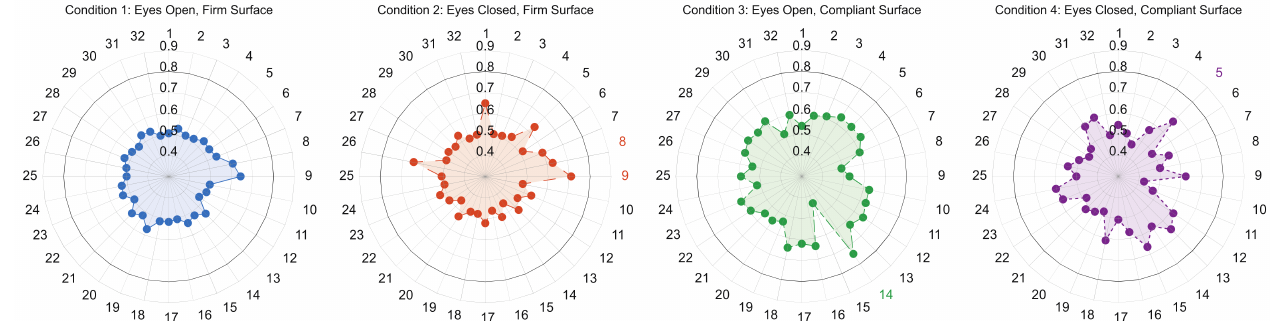
Figure 5. Spider plot representing all balance variables assessed and their linked AUC value between YA and MAA groups. Colored variable numbers round the spider plot indicate variable(s) withheld in the stepwise regression for each condition. Numbers and corresponding variable names: 1—95% Ellipse Radius (rad), 2—95% Ellipse Axis 1 Ra- dius (m/s 2 ), 3—95% Ellipse Axis 2 Radius (m/s 2 ), 4—Centroidal Frequency (Hz), 5—Centroidal Frequency (Coronal) (Hz), 6—Centroidal Frequency (Sagittal) (Hz), 7—Frequency Dispersion (AD), 8—Frequency Dispersion (Coronal) (AD), 9—Frequency Dispersion (Sagittal) (AD), 10—Jerk (m 2 /s 5 ), 11—Jerk (Coronal) (m 2 /s 5 ), 12—Jerk (Sagittal) (m 2 /s 5 ), 13—Mean Velocity (m/s), 14—Mean Velocity (Coronal) (m/s), 15—Mean Velocity (Sagittal) (m/s), 16—Path Length (m/s 2 ), 17—Path Length (Coronal) (m/s 2 ), 18—Path Length (Sagittal) (m/s 2 ), 19—Range (m/s 2 ), 20—Range (Coronal) (m/s 2 ), 21—Range (Sagittal) (m/s 2 ), 22—RMS Sway (m/s 2 ), 23—RMS Sway (Coronal) (m/s 2 ), 24—RMS Sway (Sagittal) (m/s 2 ), 25—Sway Area (m 2 /s 4 ), 26—95% Ellipse Radius ( ◦ ), 27—95% Ellipse Axis 1 Radius ( ◦ ), 28—95% Ellipse Axis 2 Radius ( ◦ ), 29—RMS Sway ( ◦ ), 30—RMS Sway (Coronal) ( ◦ ), 31—RMS Sway (Sagittal) ( ◦ ), 32—Sway Area ( ◦ 2